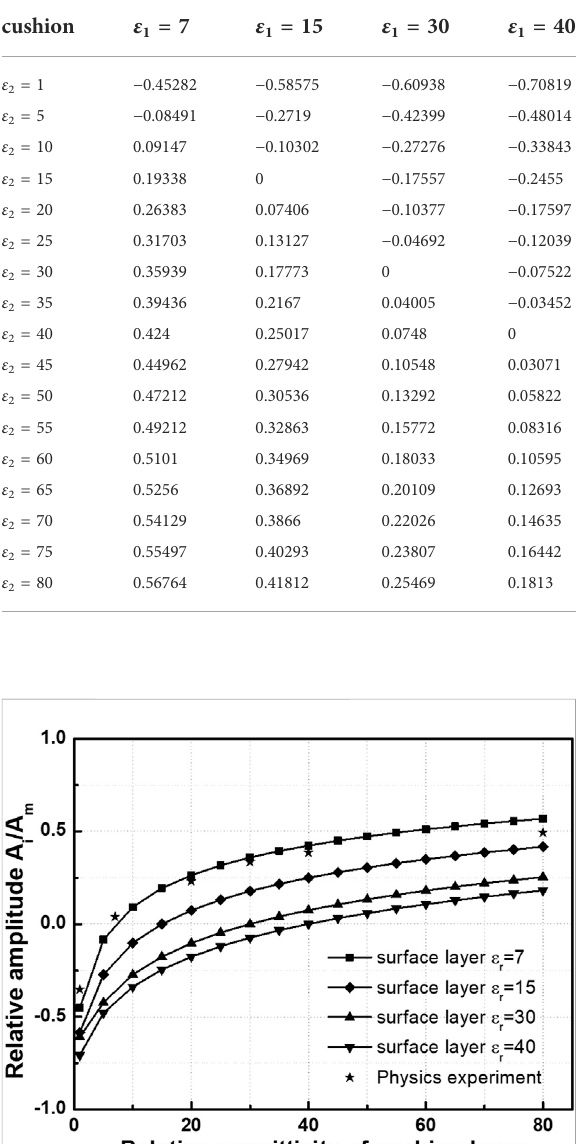
FIGURE 6 Echo amplitude curve in different